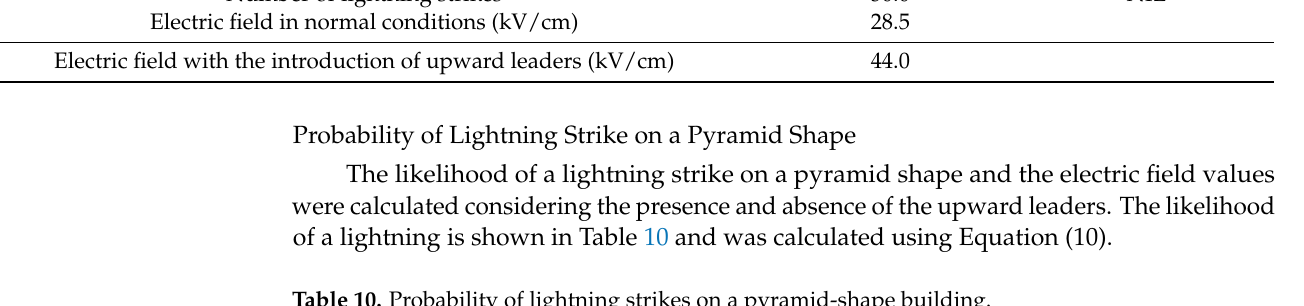
Table 10. Probability of lightning strikes on a pyramid-shape